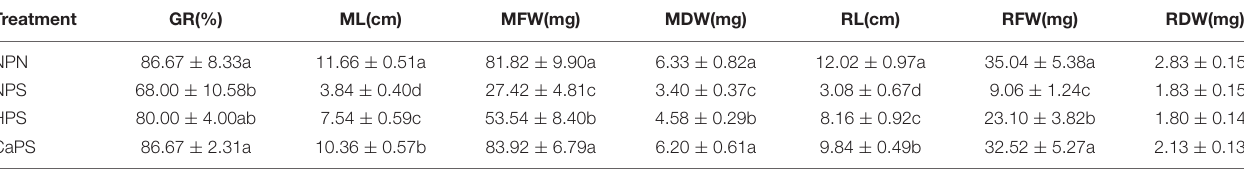
TABLE 2 | Effect of CaCl 2 priming on seed germination traits in sorghum under salt stress.